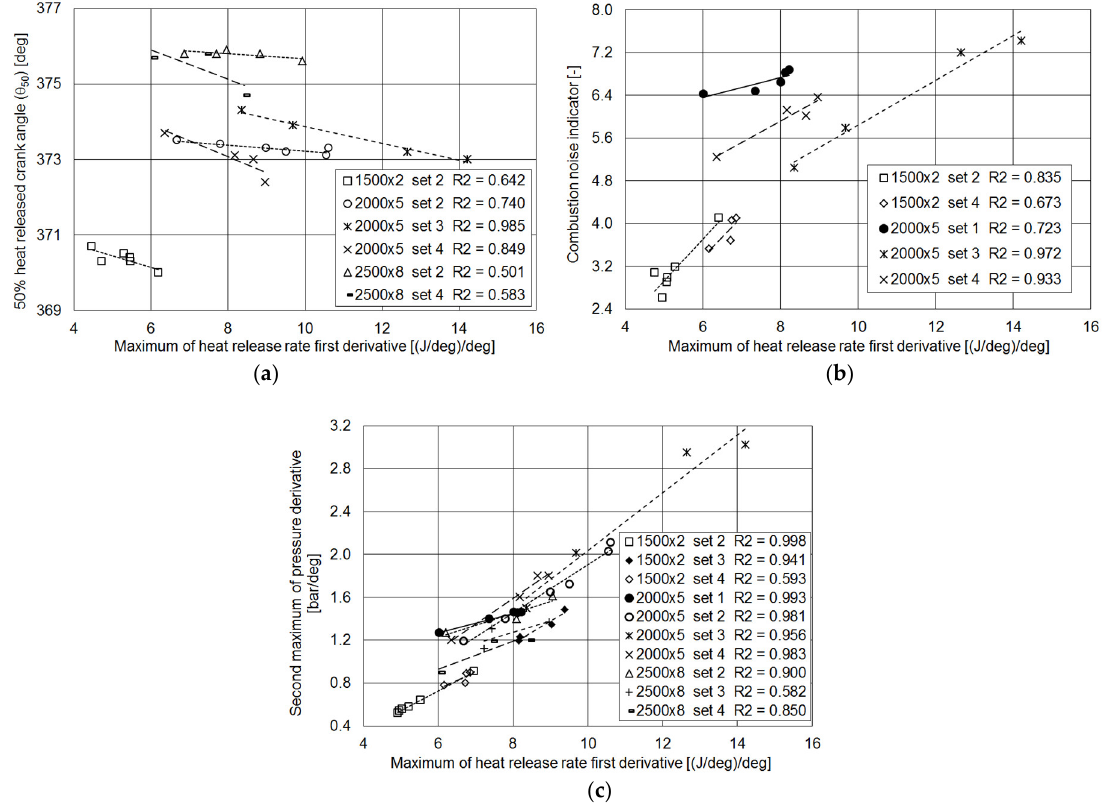
Figure 9. Relationship between (dRoHR/dθ) MAX and θ 50 ( a ), I n ( b ), (dp/dθ) MAX 2 ( c ) in different test sets.